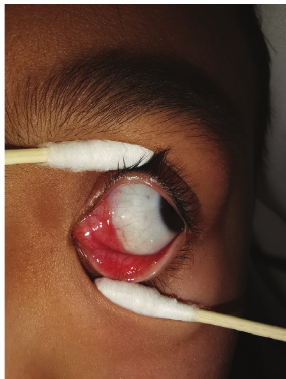
Figure 2: The healing of the conjunctival